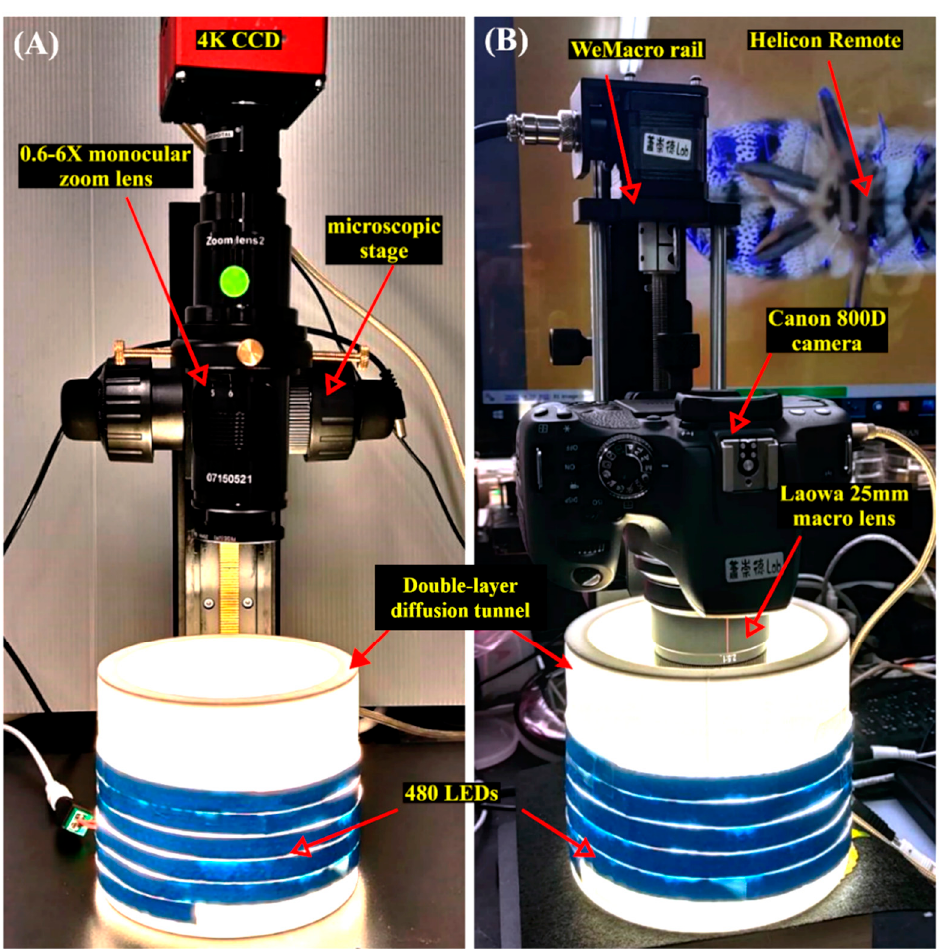
Figure 1. Overview of FACE and commercial motorized instrument settings used to conduct macro- photography in the vertical position in this study. ( A ) The instrument setup for FACE includes a 4K CCD, a microscopic stage, and a 0.6–6× monocular macroscopic lens. ( B ) The motorized stepper system is mounted with a Canon 800D digital camera equipped with a Laowa 25 mm 2.5–5× macro lens. For both methods, a 3D-printed double-layer diffusion tunnel was used to obtain uniform lighting.